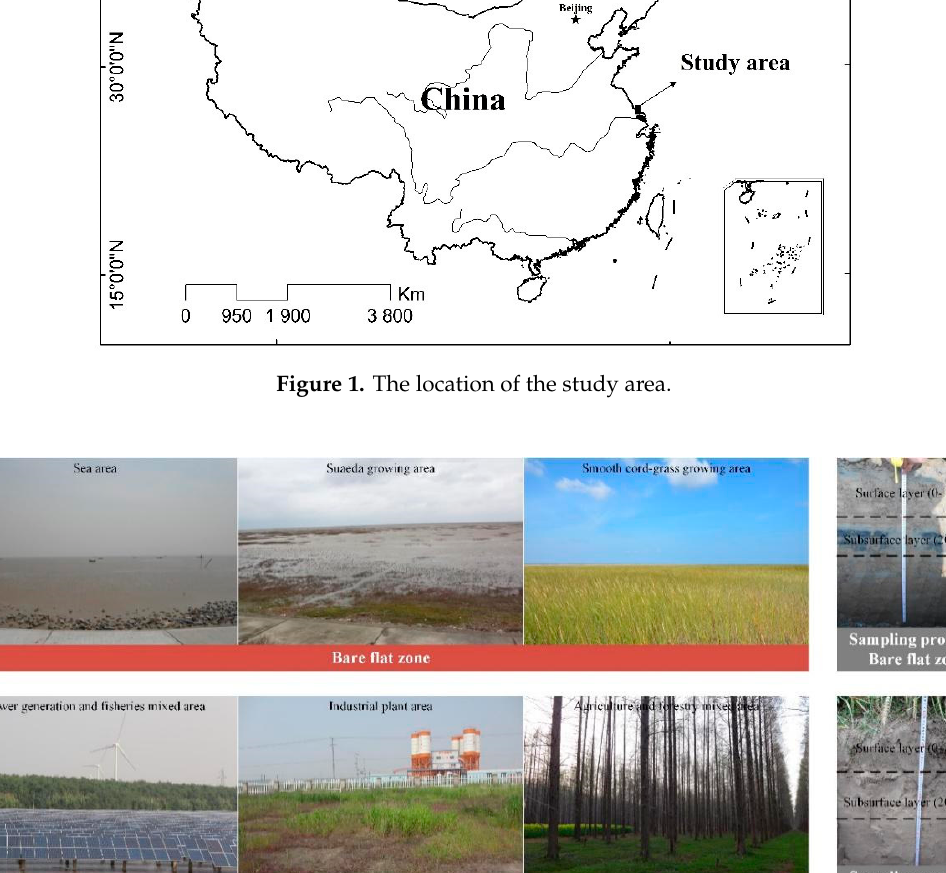
Figure 1. The location of the study area.